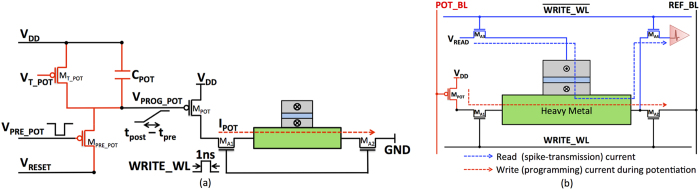
(a) Implementation of the stochastic STDP algorithm. The control signal VPRE_POT resets the node voltage VPROG_POT following an input pre-neuron spike. Once MPRE_POT turns off, VPROG_POT increases linearly at a rate determined by CPOT and the bias voltage VT_POT. The access transistors MA1–MA2 are enabled by the control signal WRITE_WL, which is asserted high at an appropriate instant following a spike fired by the connected post-neuron. Finally, VPROG_POT that is proportional to the elapsed time period between a pair of pre-and post-neuron spikes (tpost–tpre) is sampled by MPOT to generate the required write current IPOT. A similar discussion is valid for the depression circuit, wherein the programming current is passed in the opposite direction. (b) Bitcell configuration of an MTJ-HM binary synapse. The bitline POT_BL drives the potentiation circuit path, which is conditionally enabled by the write wordline (WRITE_WL). The reference bitline (REF_BL) is driven to ground. The spike-transmission path is driven by the pre-neuronal voltage spike (VREAD), and is active whenever the WRITE_WL is driven low.